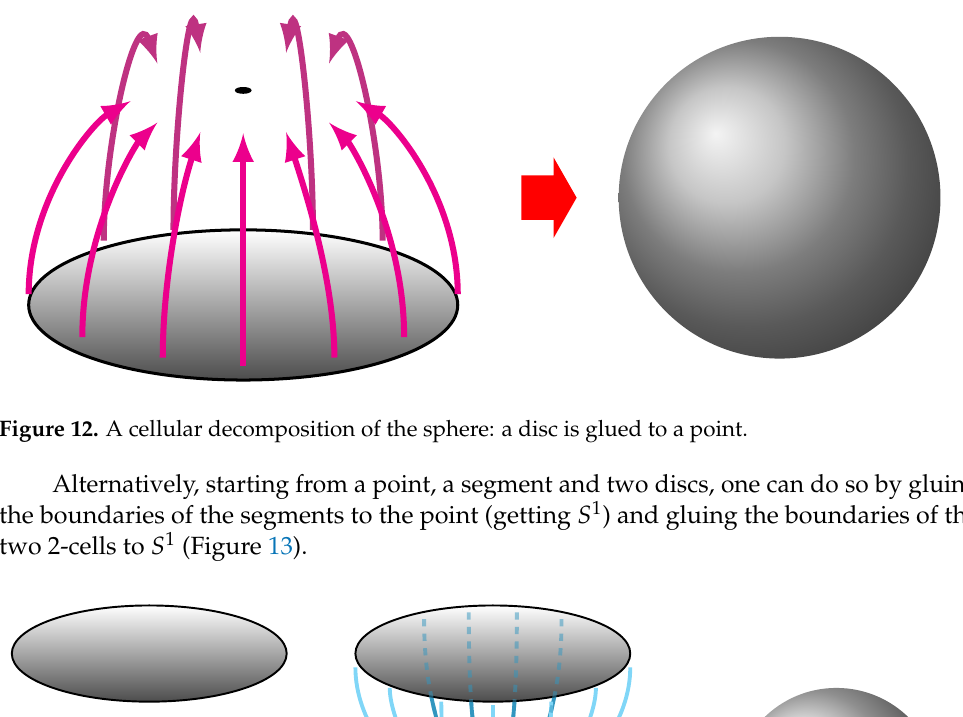
Figure 13. A different cellular decomposition of the sphere.